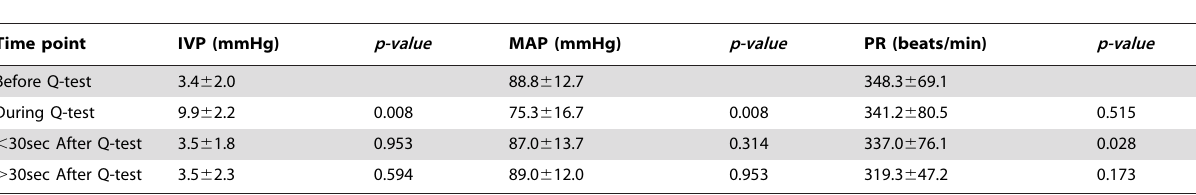
Table 1. Changes in intraventricular pressure, mean arterial pressure, and pulse rate due to Queckenstedt’s test.